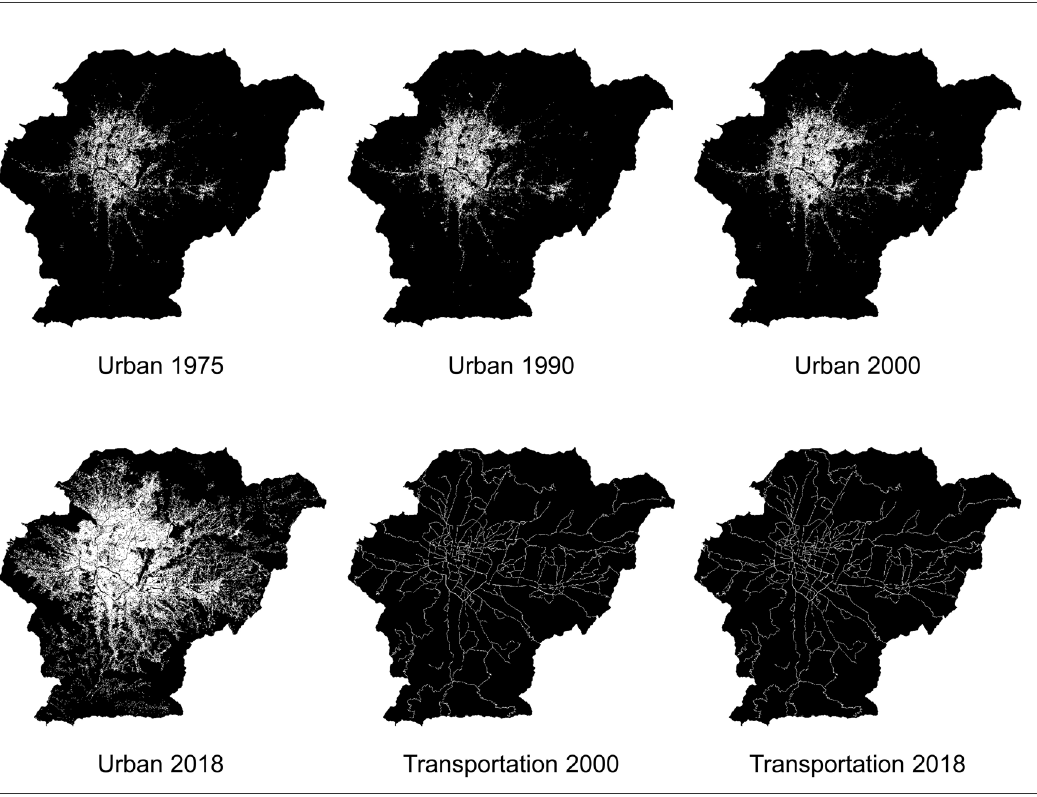
Figure 3. Urban extent and Transportation input data for